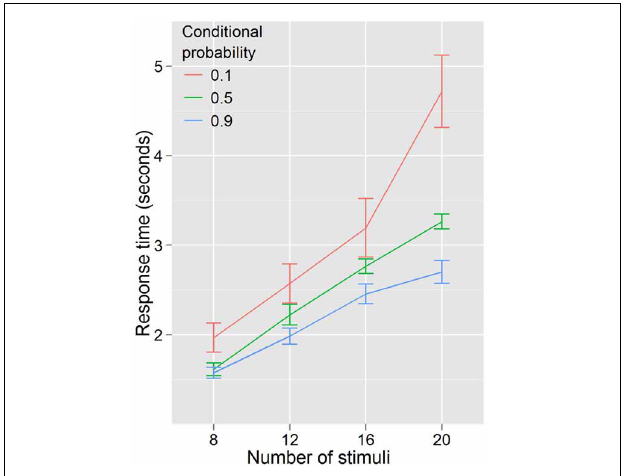
FIGURE 3 | RTs by distractor number for Experiment 1. The higher the conditional probability, the faster and more efficient the search.